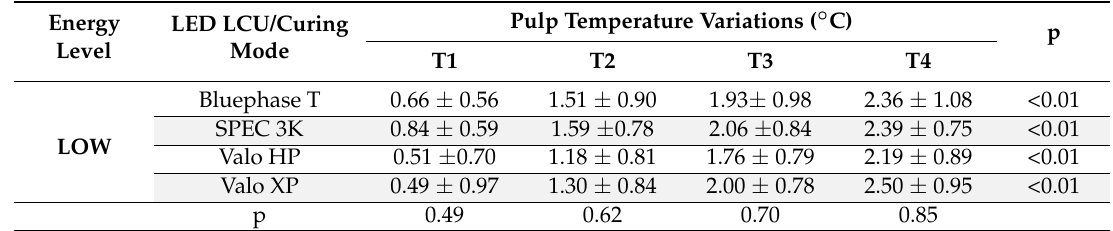
Table 2. Mean pulp temperature variation above baseline value measured at the end of each four light-curing steps among low-energy-level curing modes.